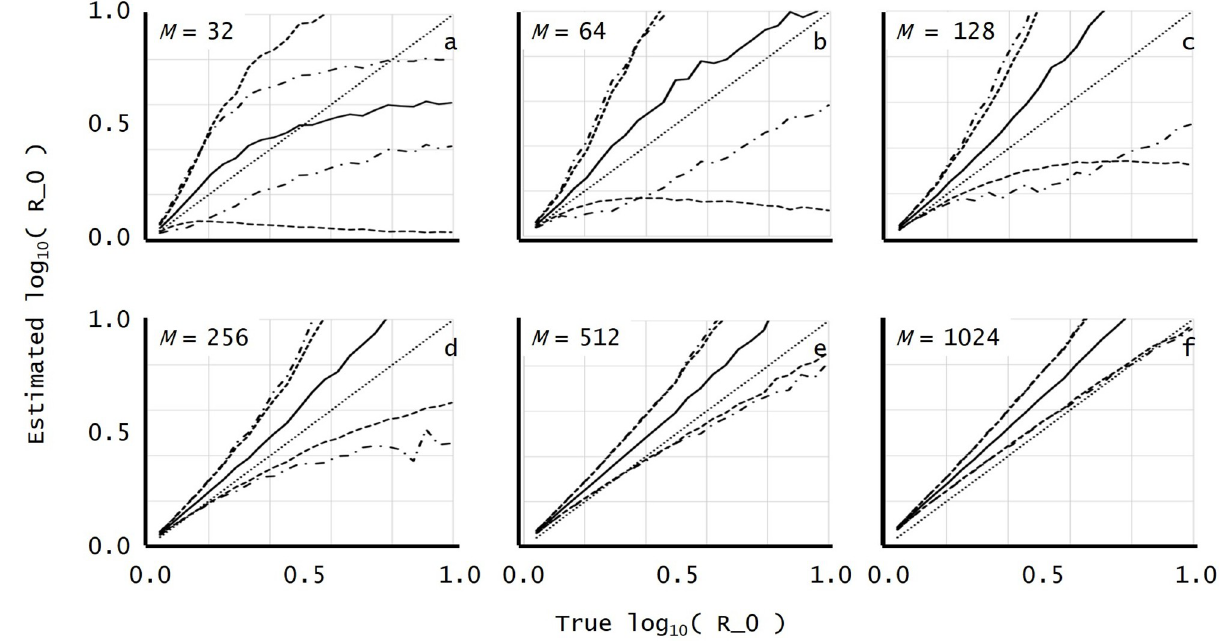
Fig 2. Plots for the maximum likelihood estimate (integral approximation ^ r ð I Þ